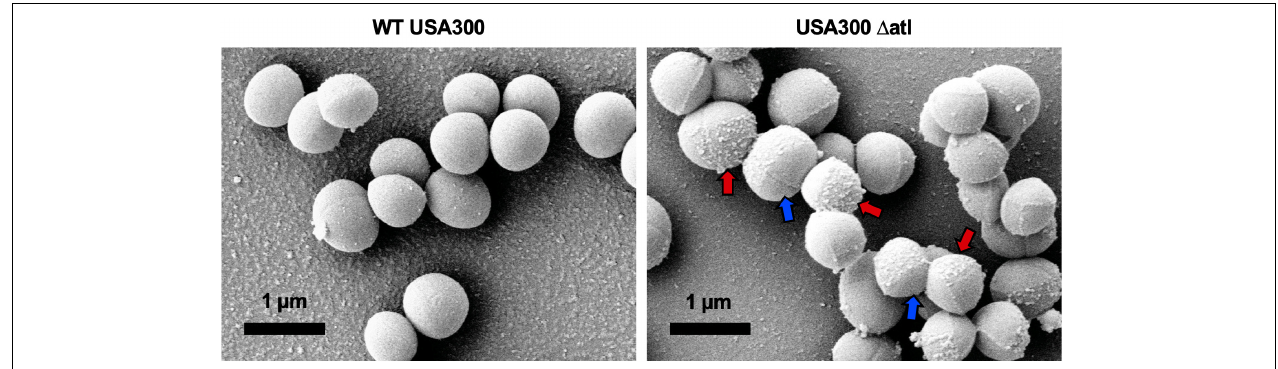
FIGURE 3 | Deletion of atl results in aberrant S. aureus cell wall morphology. Cultures of WT USA300 and (cid:49) atl were grown on glass coverslips and processed for SEM imaging ( n = 3 independent experiments). High-magnification images show the characteristic “rough” cell wall of the (cid:49) atl strain compared to the smooth cell wall of WT S. aureus . Red arrows denote regions of “rough” surfaces that are primarily in older regions of the cell wall, while newly separated cells show “smoother” surfaces in regions of newly synthesized cell wall, noted by blue arrows.